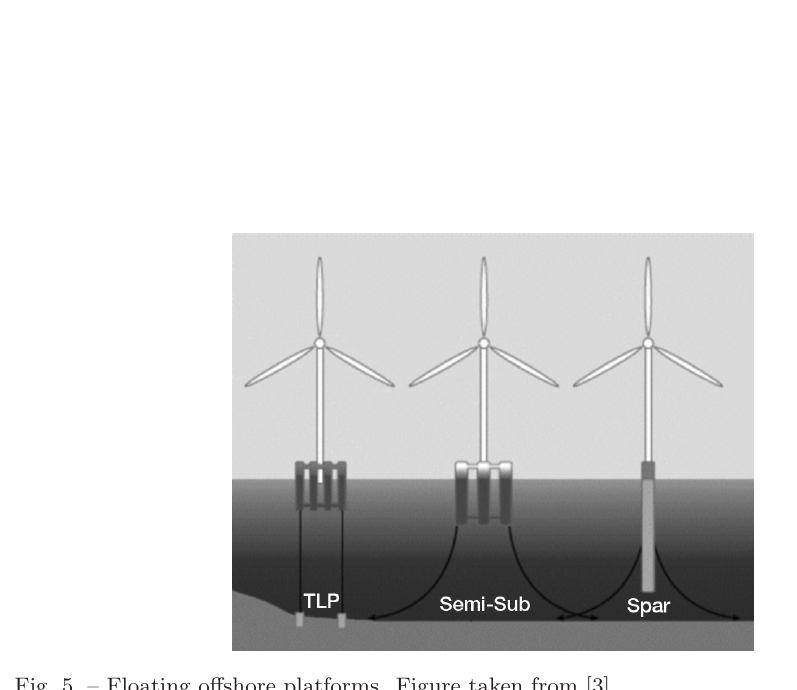
Fig. 5. – Floating offshore platforms. Figure taken from